Question: Condense the content of this figure into a single sentence.
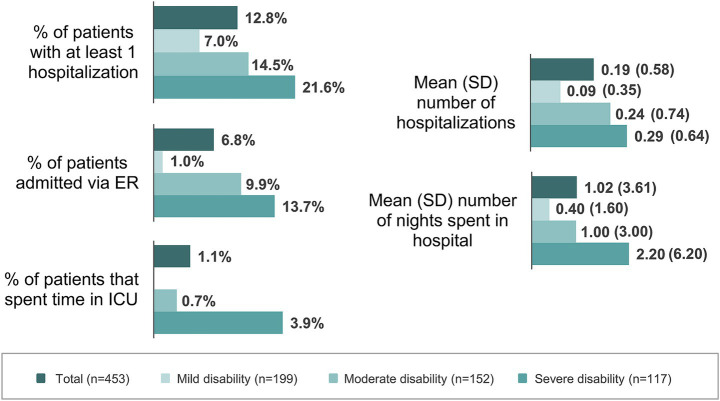
Answer: Distribution of hospitalizations, nights spent in hospital, ER admissions, and ICU stays. ER: emergency room; ICU: intensive care unit; n : sample size; SD: standard deviation.